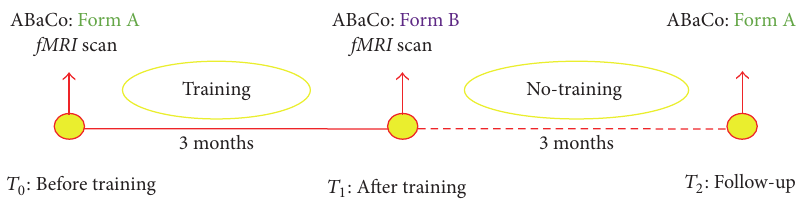
Figure 1: Graphical representation of the experimental